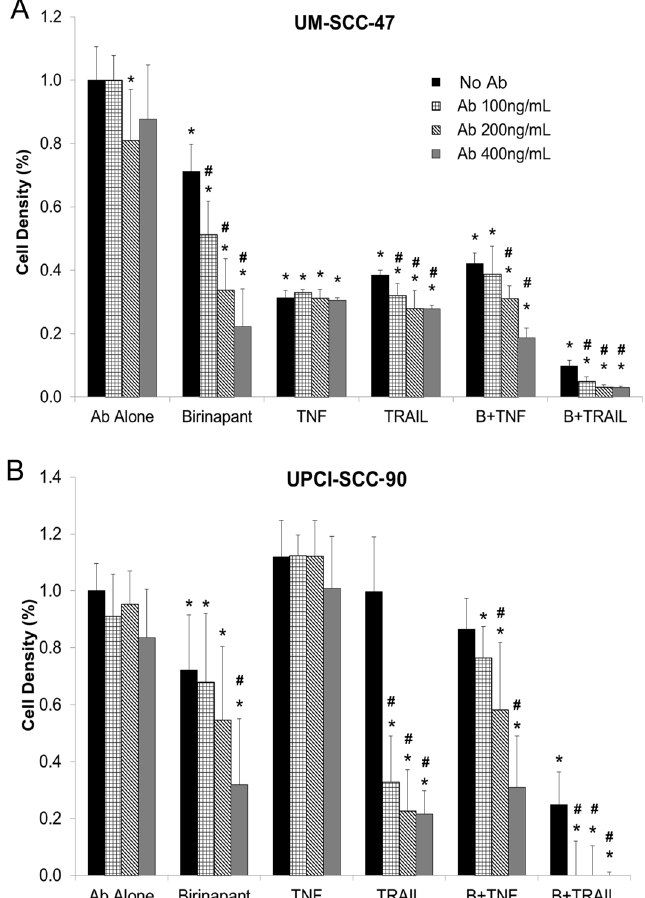
Figure 5. Antiproliferative effect of birinapant is enhanced by TRAIL, TRAILR2 antibody, and TNF-α in combination treatment. Inhibition of cell density was measured by XTT after administering birinapant, TRAIL, TNF-α, TRAILR2 antibody alone and in combination on HPV(+) cell lines UM-SCC-47 cells ( A , day 3), and UPCI-SCC-90 ( B , day 5). Independent experiments were performed to titrate the drug doses, the combination, and different time points previously. Error bars, the standard deviation of 6 replicates from a representative of independent experiments. * denotes a significant p-value when compared with no treatment control, the first column. # denotes a significant p-value when compared with no antibody control of each treatment group. p < 0.05 by Student’s t